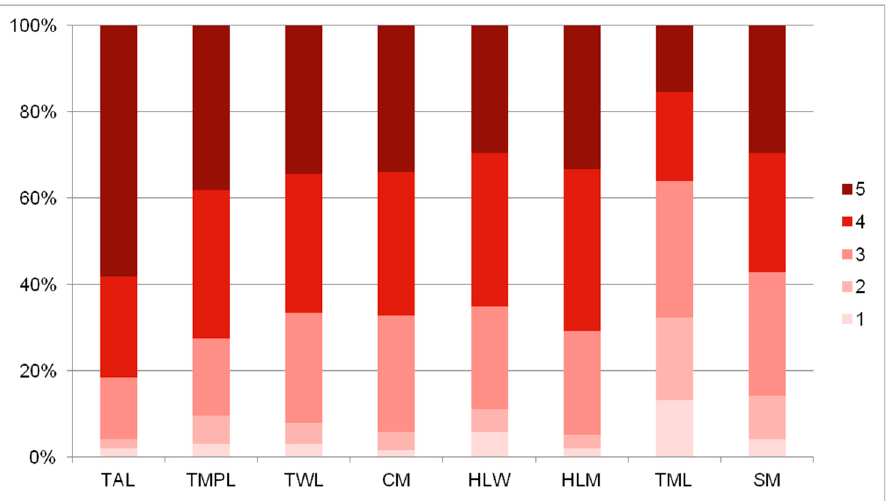
Figure 10. The need for landscape protection—Which types of biocultural landscape do you find the most endangered/degraded and in need of the most protection? (Legend: 5—the highest pro